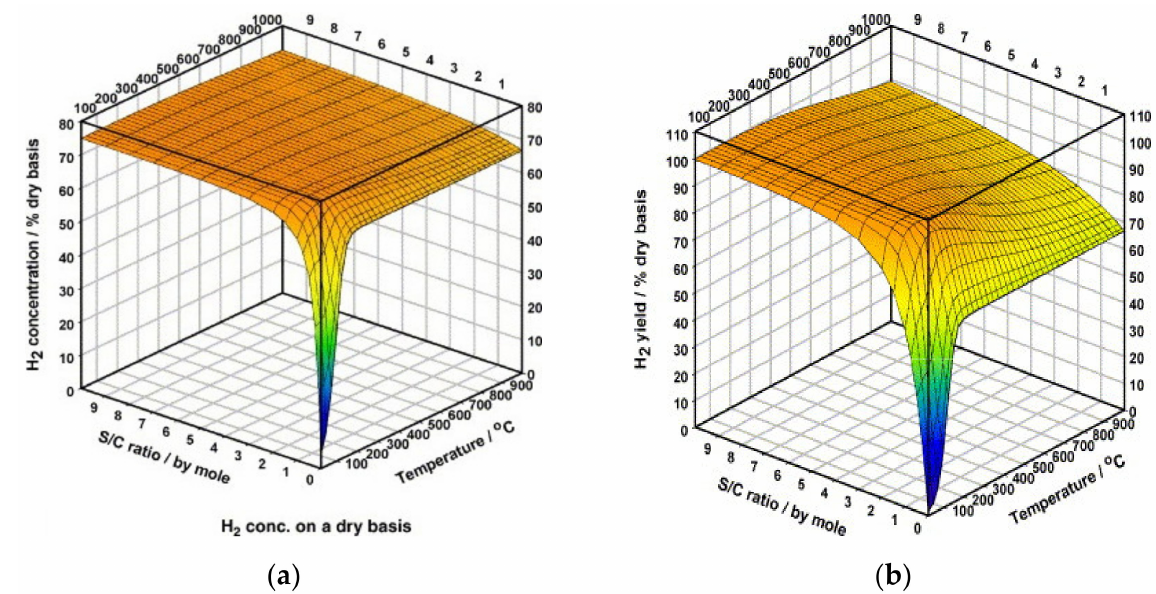
Figure 2. ( a ) Equilibrium hydrogen concentration on dry basis from SRM as a function of S/C ratio and temperature. ( b ) Equi- librium hydrogen yield from SRM as a function of S/C ratio and temperature. (Adapted from [61], copyright 2006, Elsevier.)